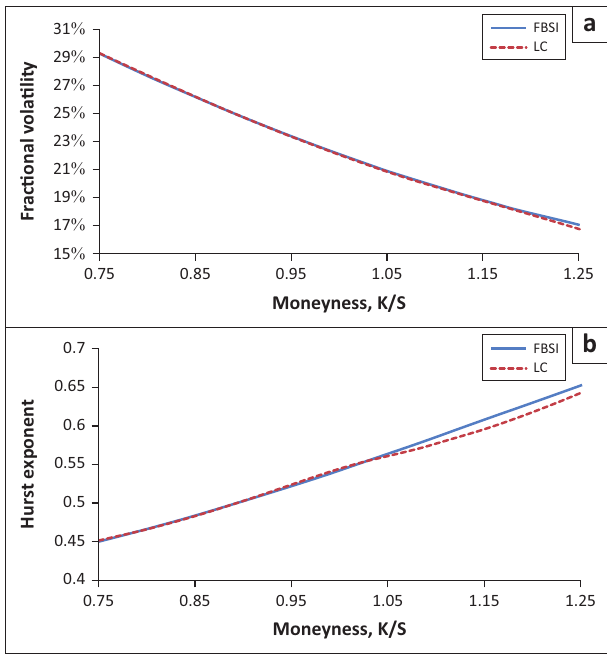
FIGURE 6: Calibrated (a) fractional volatility and (b) Hurst exponent skews from the FBSI and LC models as at 30 May 2011.